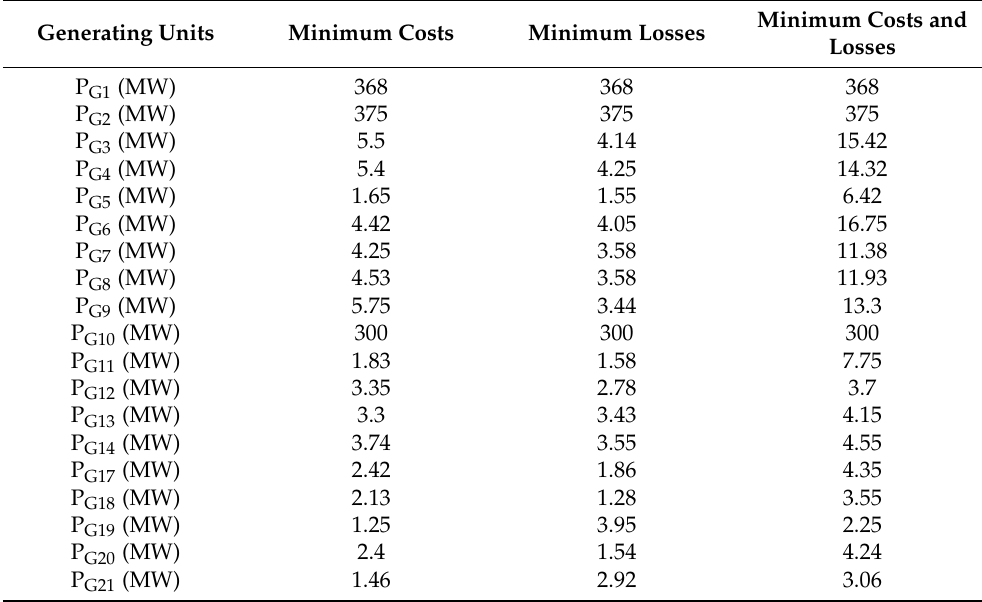
Table 6. Optimal fossil fuel power considering different objective functions for Nigeria system.